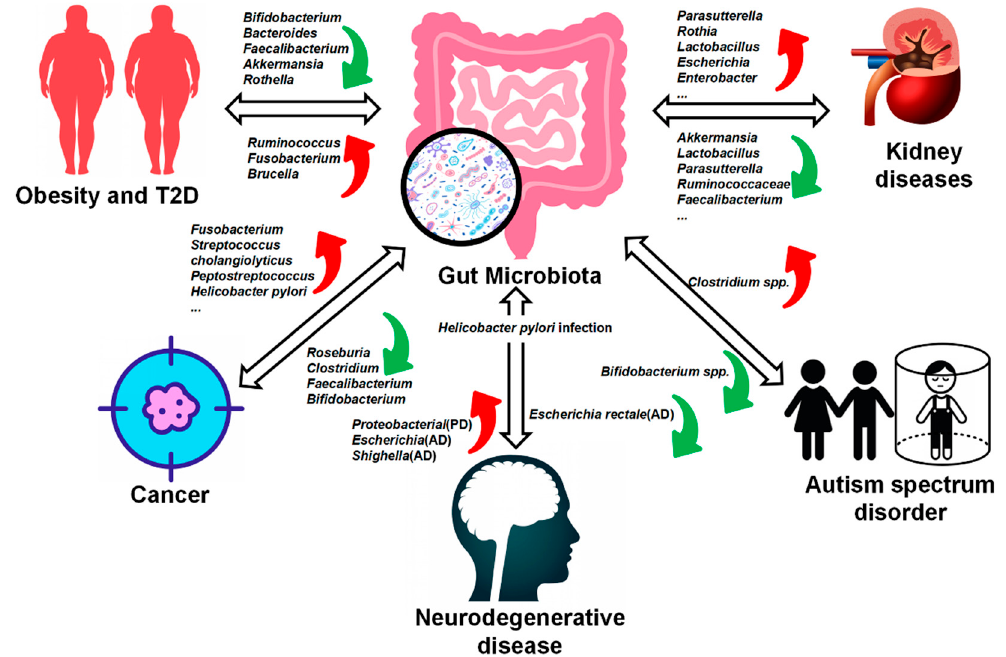
Figure 1. The relationship between gut microbiota and disease. Many diseases alter the composition of the gut microbiota, which also plays a key role in disease progression. Gut microbiota changes in patients with obesity, Type II Diabetes(T2D), cancer, psychiatric disorders, autism spectrum disorder, and so on. Metabolites of gut microbiota have also been implicated in some disease processes, such as cardiovascular disease. Gut microbiota offers new direction for disease treatment. Note: Alzheimer’s disease, AD; Parkinson’s disease (PD). The meaning of a symbol in the table: red arrow, up-regulated; green arrow,